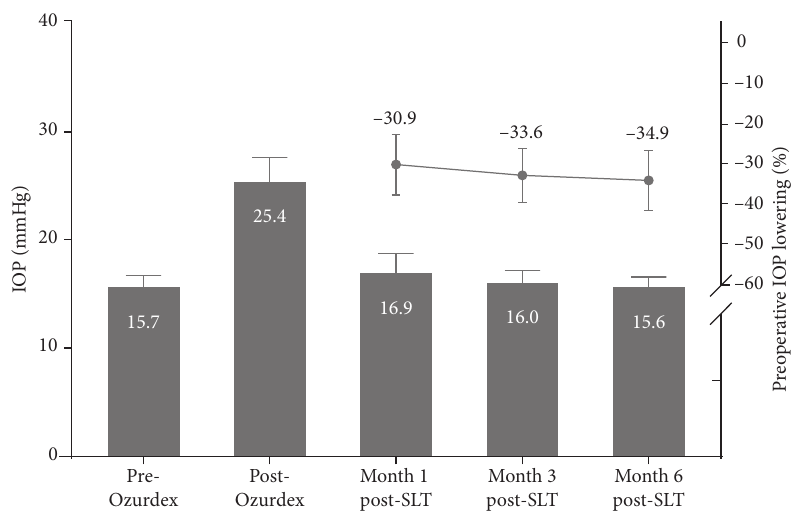
Figure 1: Intraocular pressure lowering after the SLT procedure with a follow-up of 6 months.